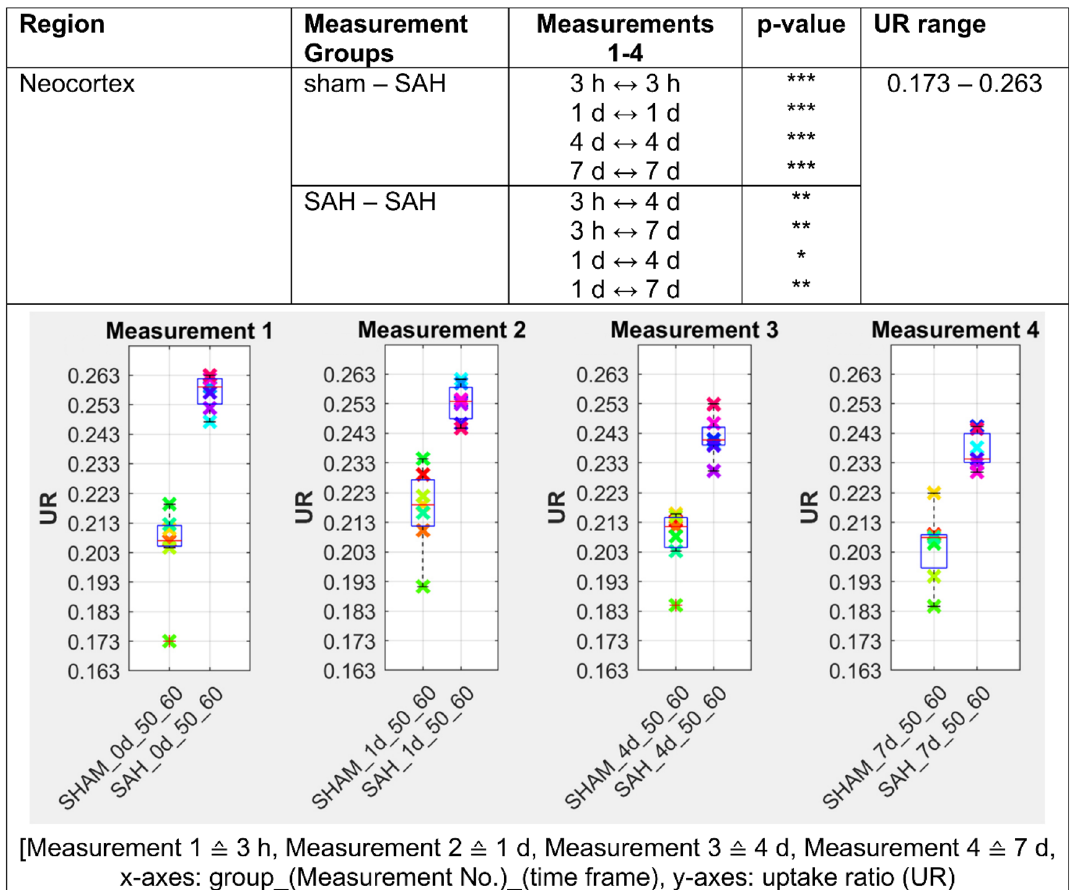
Figure 4. The [ 18 F]FDG uptake in SAH animals is highly significant (p ≤ 0.001) elevated in the neocortex compared to the sham operated control and stays significantly higher (p ≤ 0.001) up to day 7 following SAH. p ≤ 0.05 *; p ≤ 0.01 **; p ≤ 0.001